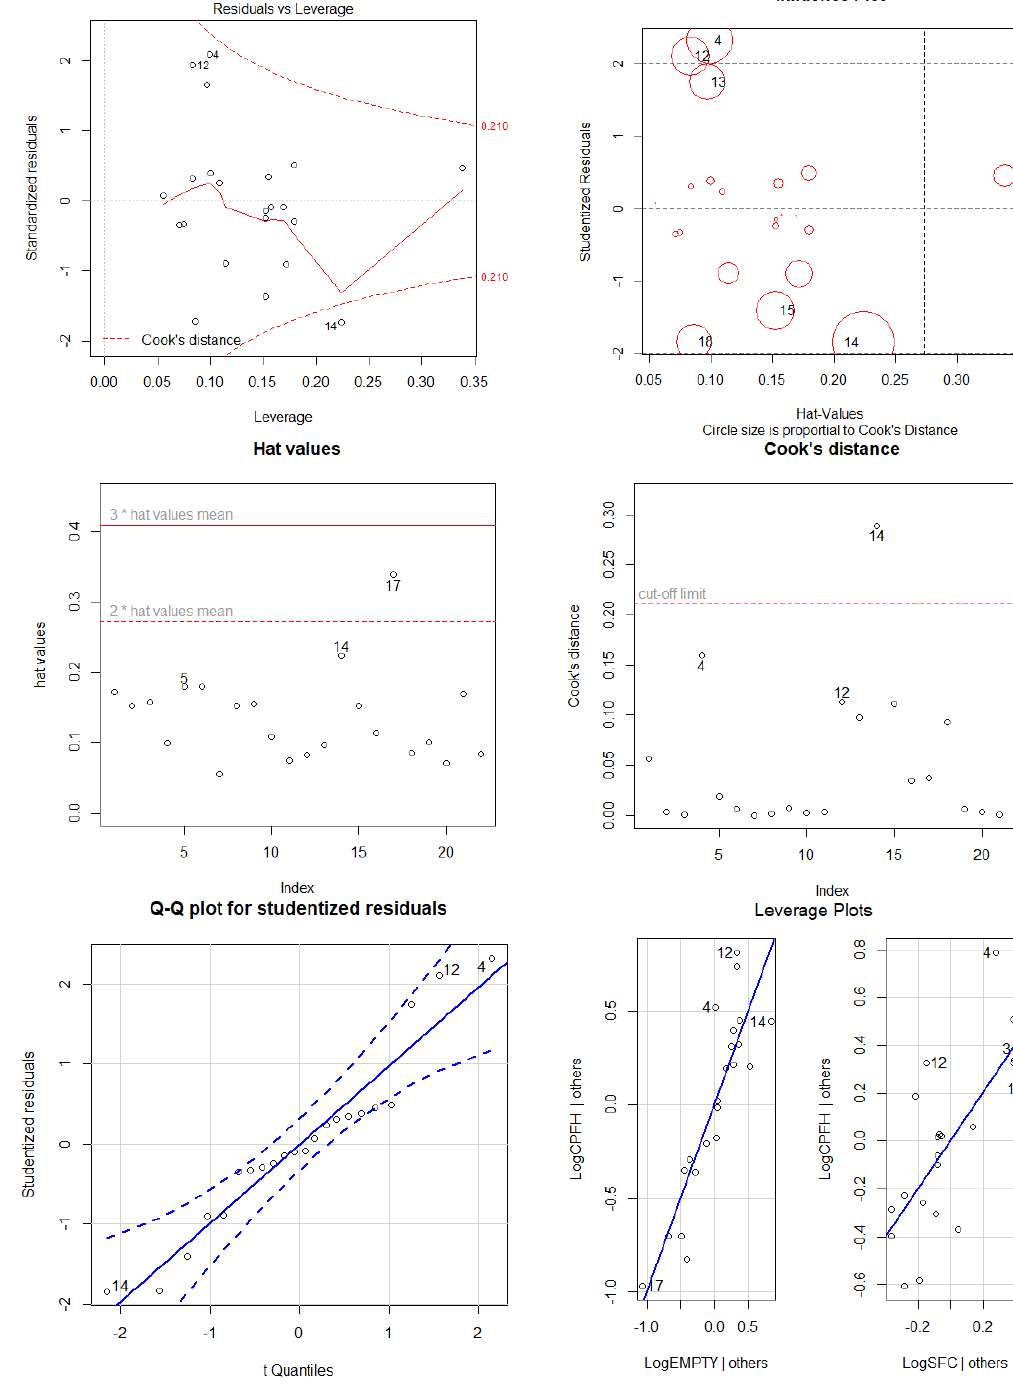
Figure 7. Typical residual plots.